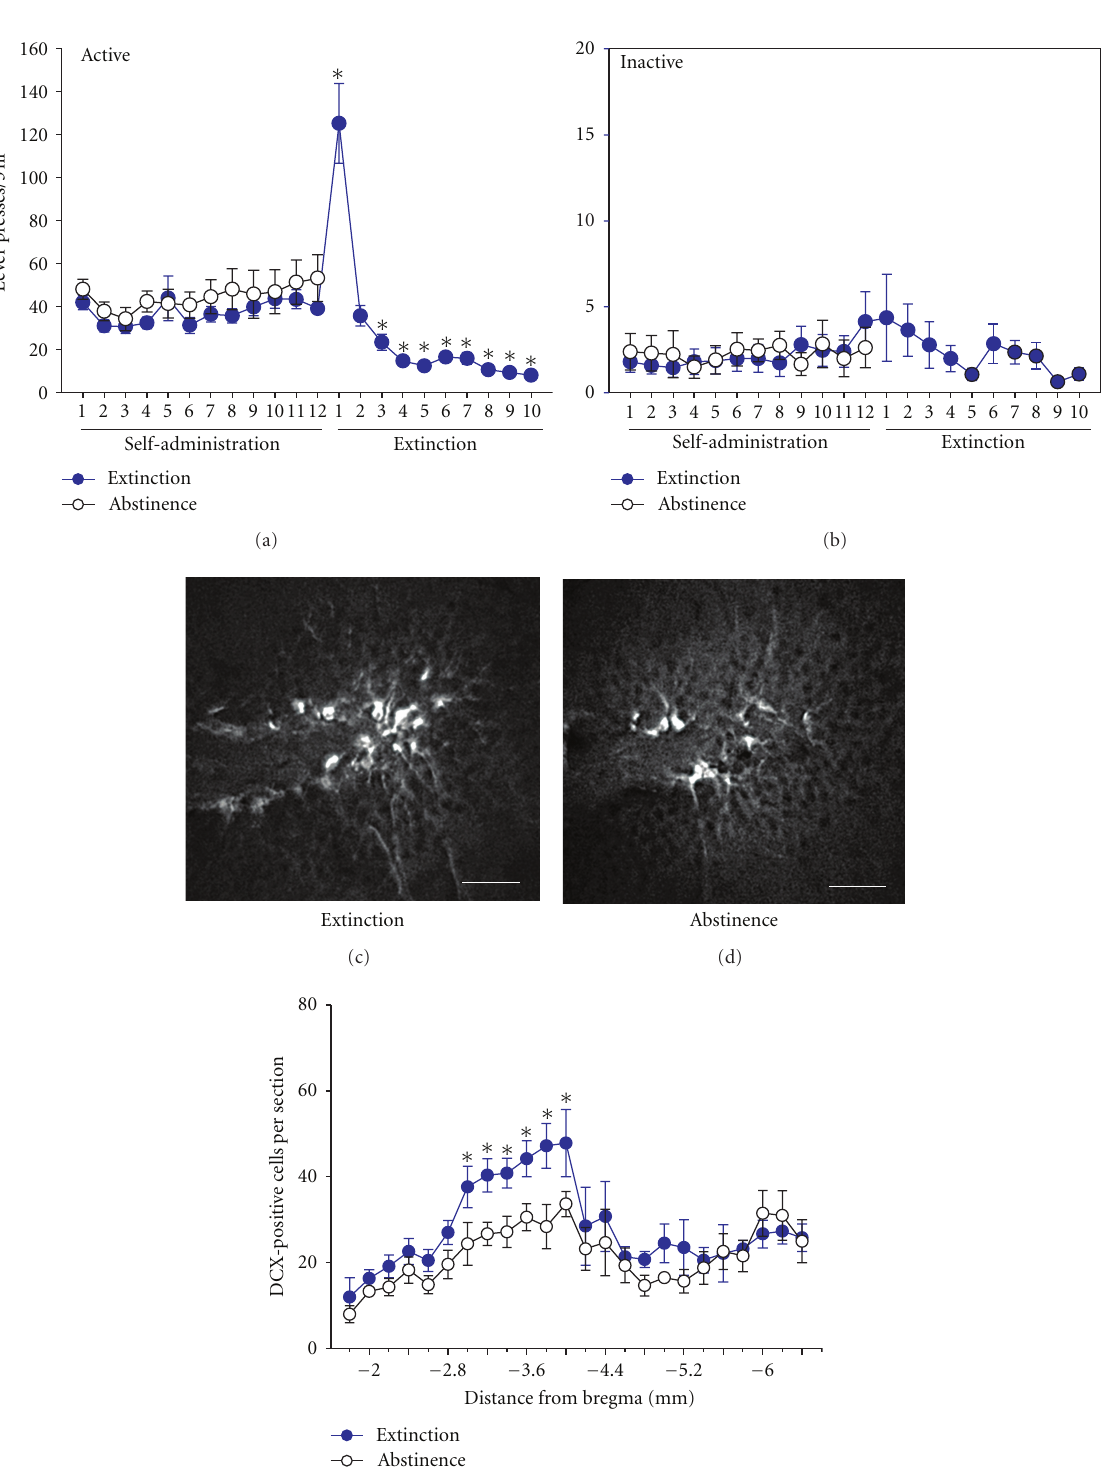
Figure 2: Extinction training increases DCX immunoreactivity in the DG following heroin self-administration (Experiment 1). (a) Active and (b) inactive lever presses during heroin self-administration and extinction. Animals undergoing extinction ( n = 15) were subjected to 10 days of extinction training following the last day of heroin self-administration, while animals undergoing forced abstinence ( n = 13) remained in the home cage. ∗ P < 0 . 05 versus the average of the last two days of heroin self-administration. (c) and (d) Representative DCX immunostaining at 400x magnification in the DG ( ∼ 3.8mm posterior to bregma) from animals subjected to extinction (c) or abstinence (d). Scale bar = 35 µ m. (e) Quantification of DCX immunoreactivity along the DG neuraxis in a subset of animals subjected to extinction or abstinence ( n = 8 per group). ∗ P < 0 . 05 versus the abstinence group at the same coronal plane relative to